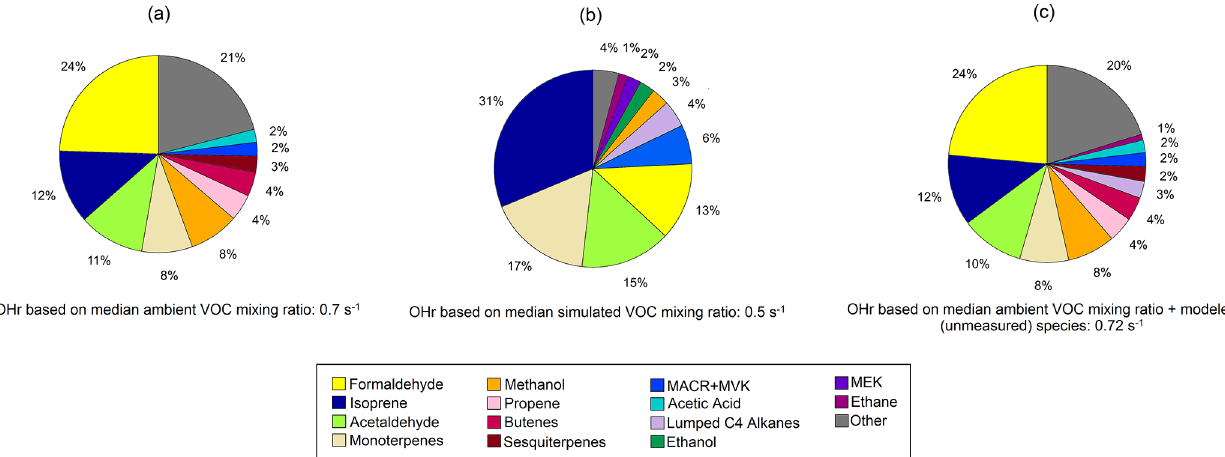
Figure 9. Pie charts of calculated OH reactivity (OHr) for observed (a) and simulated (b) species at Toolik Field Station (TFS). Also shown is our best guess of OHr at TFS with ethane and the other higher alkanes (Lumped C 4 alkanes) estimated by the model (c) . Relative contribution of individual compounds is calculated using median campaign mixing ratios and OH rate constant for that species. Rate constants for individual VOCs are compiled from previous literature, and rate constants of the dominant species or isomer at the detected PTR-ToF mass are used (Koss et al., 2018; Atkinson et al., 2004, 2006; Atkinson and Arey,